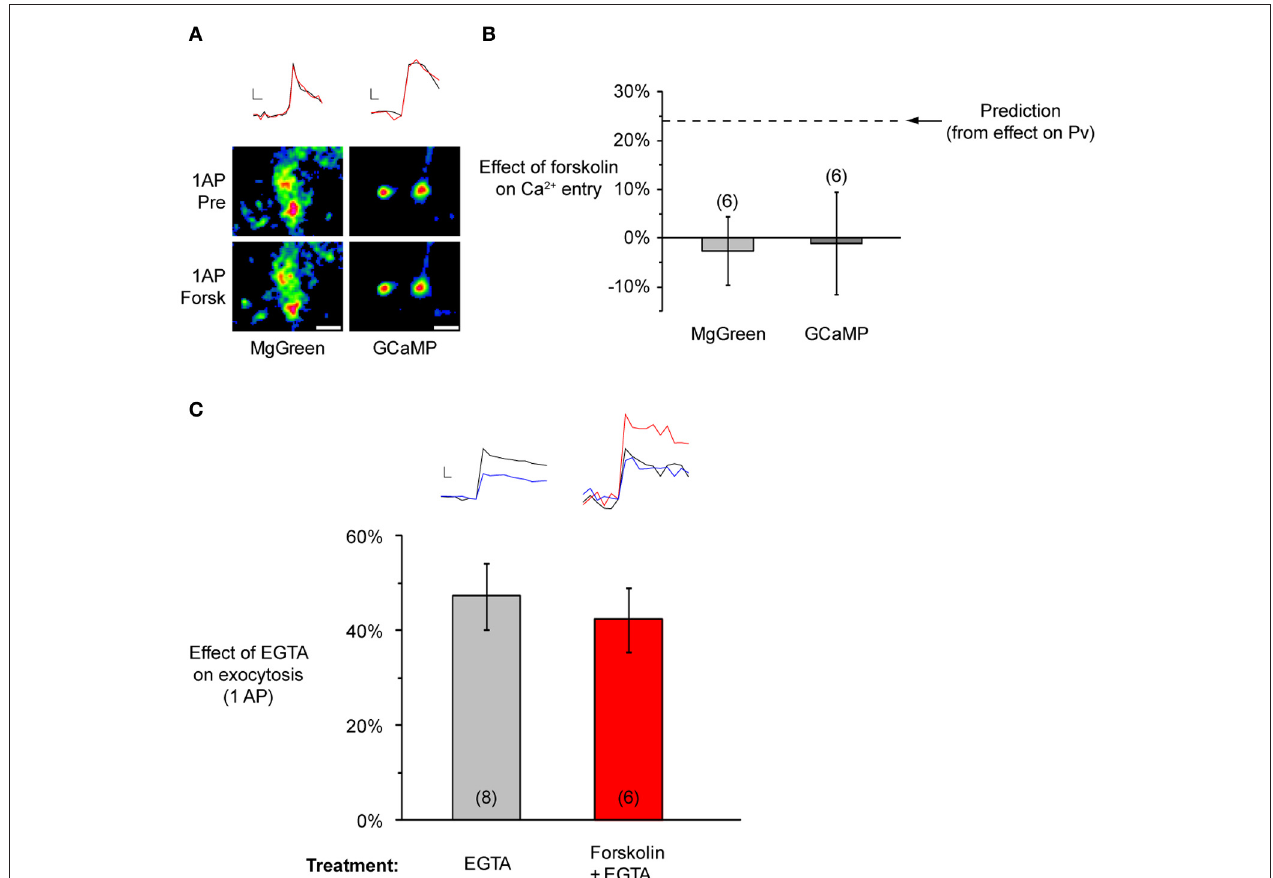
FIGURE 7 | Forskolin does not affect calcium entry or coupling between Ca 2 + and primed vesicles. (A) Representative experiments showing no effect of forskolin on Ca 2 + entry. Top: Sample traces from a MgGreen (left) or GCaMP3 (right) experiment before (black) and after forskolin (red). Scale bar MgGreen: 20% of baseline peak, 25ms. Scale bar GCaMP3: 20% baseline peak, 50ms. Bottom: Representative responsive regions from each experiment. Each set of images corresponds to a subset of responsive regions included in the analysis. Images are averages of single AP difference images ( n = 10 trials for MgGreen, n = 30 trials for GCaMP3), smoothed for presentation purposes only. Scale bar = 2 μ m. (B) No effect on single AP